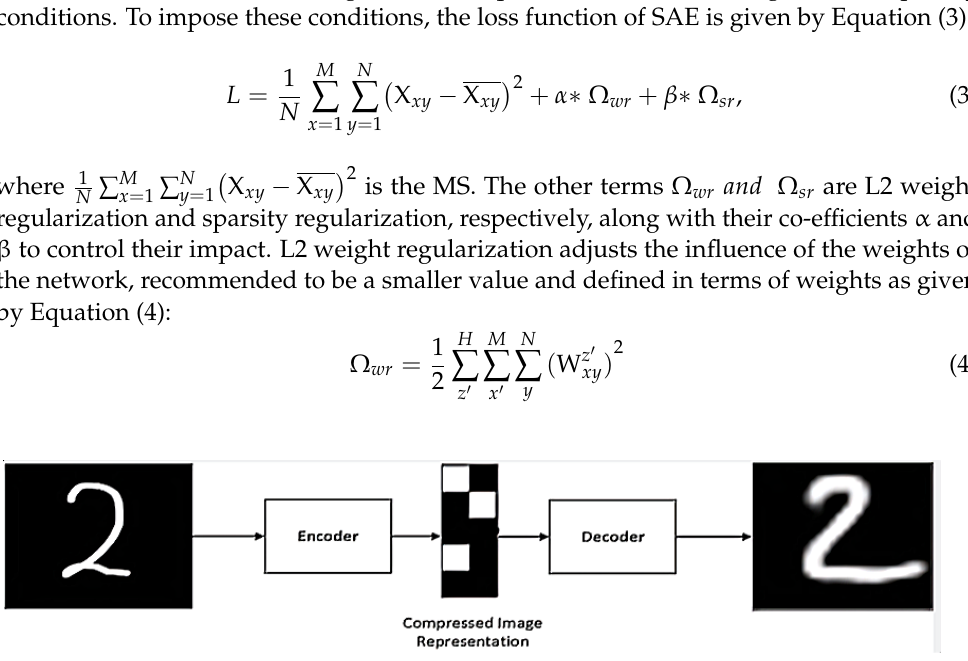
Figure 6. Illustration of auto-encoder functionality.